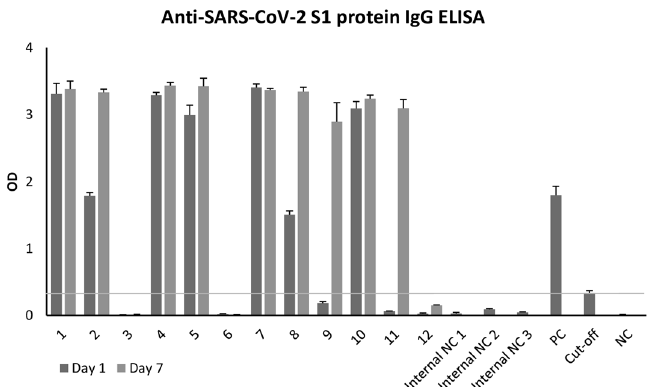
Figure 2. Anti-SARS-CoV-2 S1 protein IgG ELISA. Patient serum was tested for IgG isotype antibodies directed against subunit 1 of the SARS-CoV-2 spike protein (S1). Patients with a higher optical density (OD) measured at λ = 450 nm than the provided cut-off were labeled positive for IgG isotype antibodies directed against the S1 protein. Average ODs and standard deviations are shown in the bar chart. n = 3.